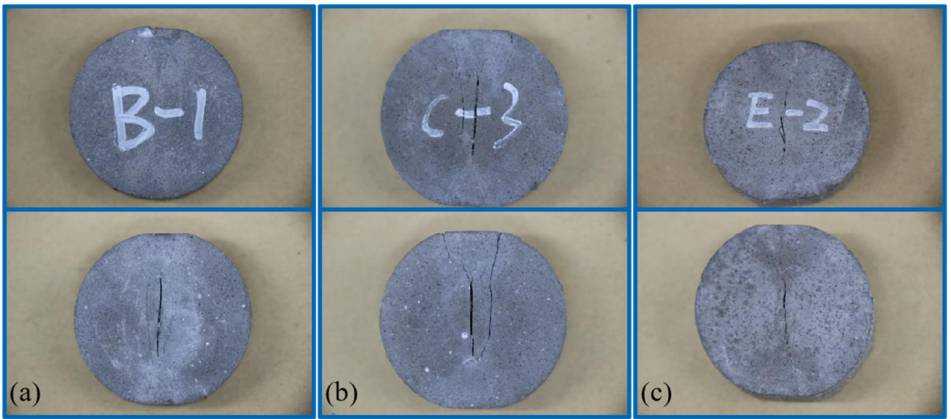
Figure 9. Splitting fracture surface of some cement stone specimens: ( a ) 50 ◦ C—10 MPa, ( b ) 80 ◦ C—20 MPa, and ( c ) 140 ◦ C—40